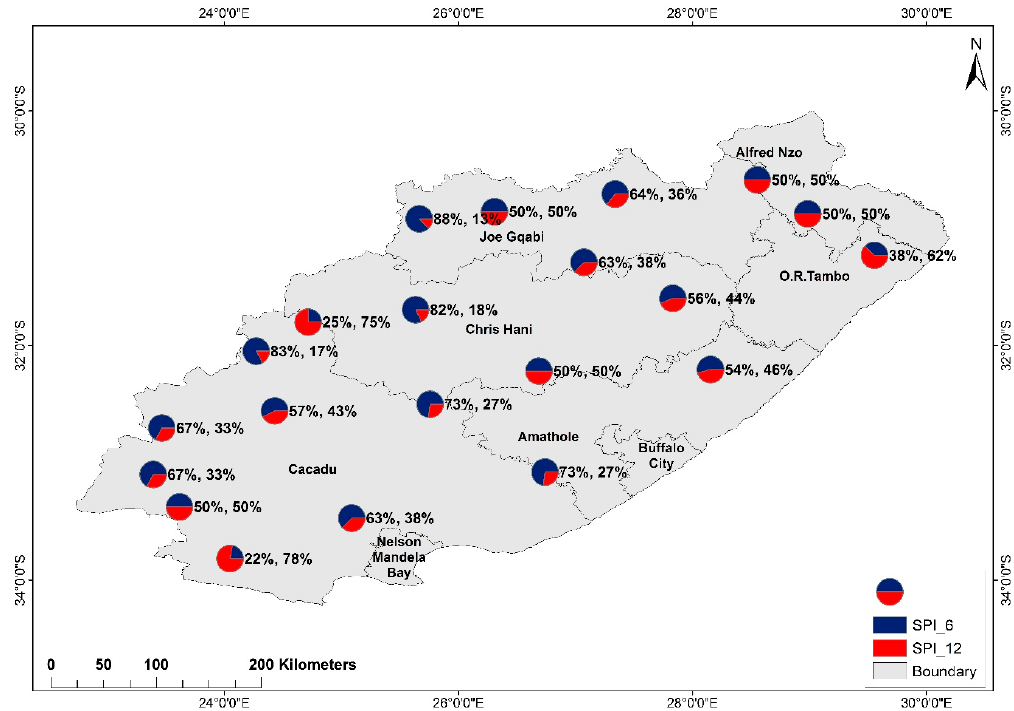
Figure 3. Proportion of occurrence of SPI-6 and SPI-12 drought episodes recorded across the Eastern Cape province, South Africa.